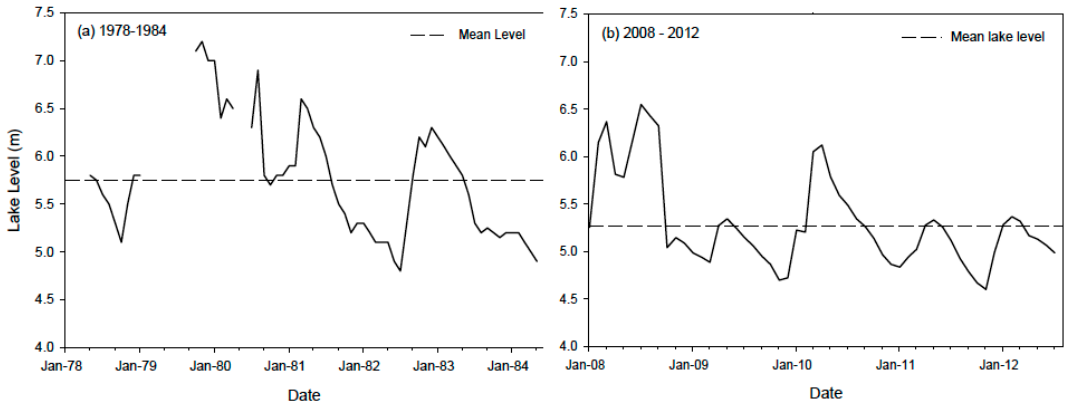
Figure 2. Lake level records for two different periods: ( a ) 1978–1984 and ( b ) 2008–2012. Figure 3. Lake level records for two different periods: ( a ) 1978–1984 and ( b )